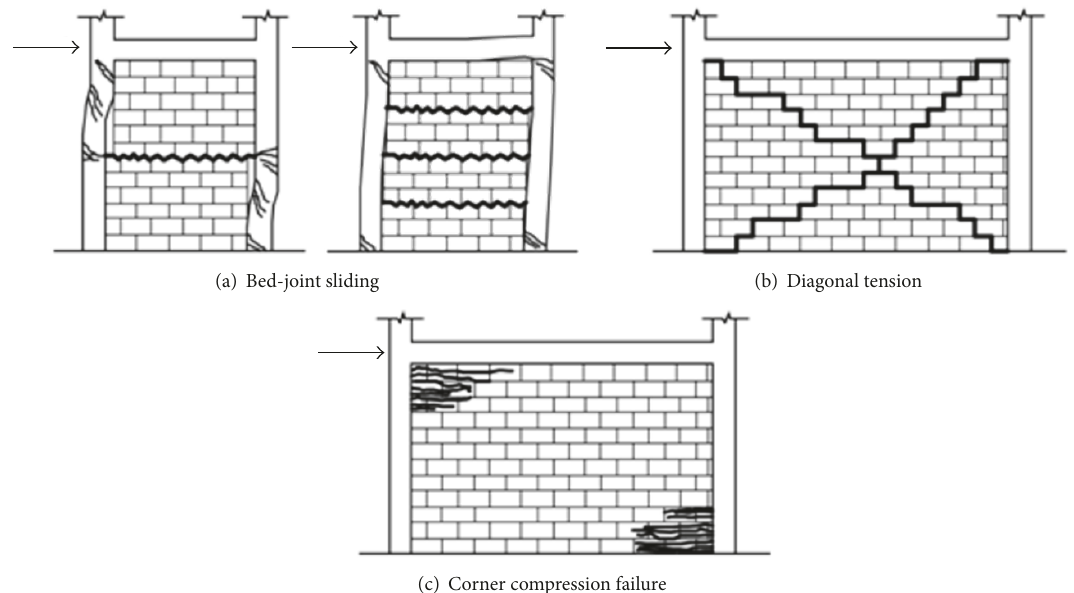
Figure 1: Typical failure modes of masonry infill walls under in-plane loading